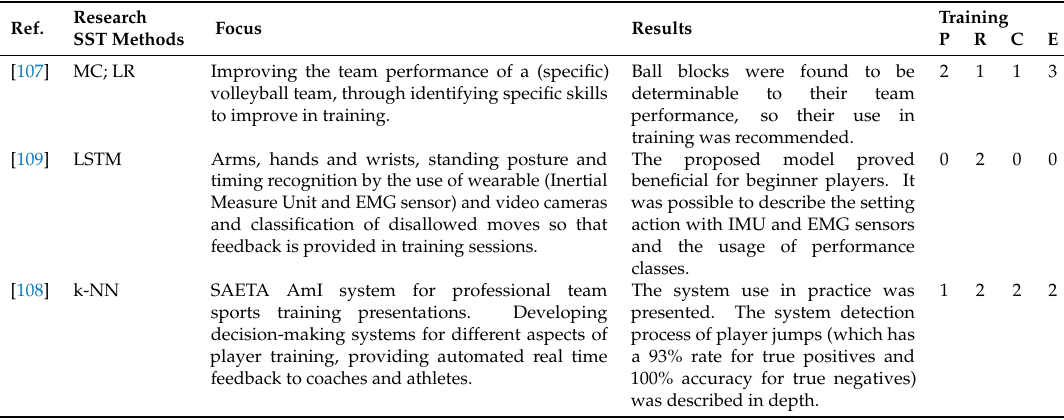
Table 16. Identified studies in the domain of volleyball.